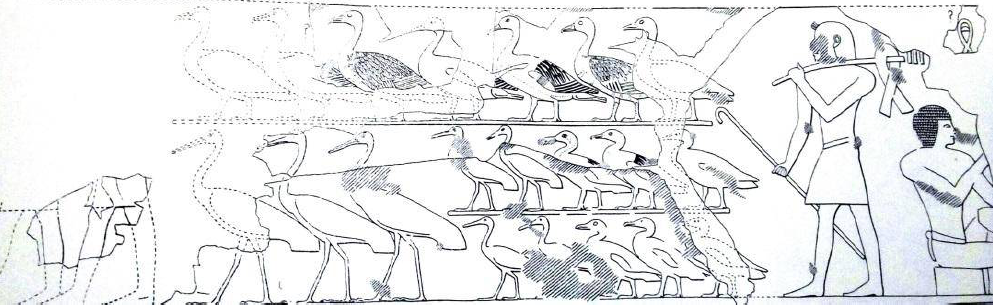
Figure 3. Man leading large birds from the tomb of Puyemra (TT39), El-Khokha (Western Thebes), 18th Dynasty (Image taken from Davies and de Garis 1922, pl. 12).